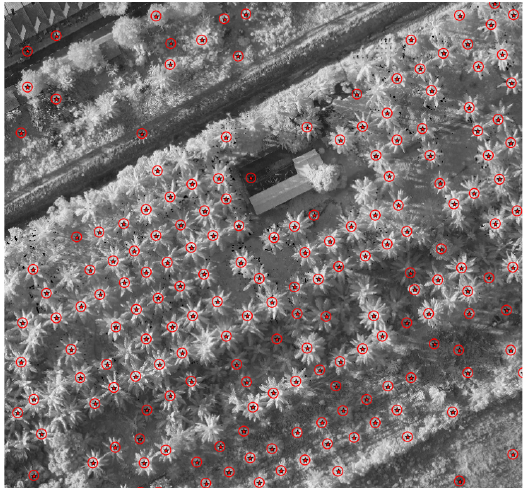
Figure 12: Object map of Image 01 with δ = 100 px